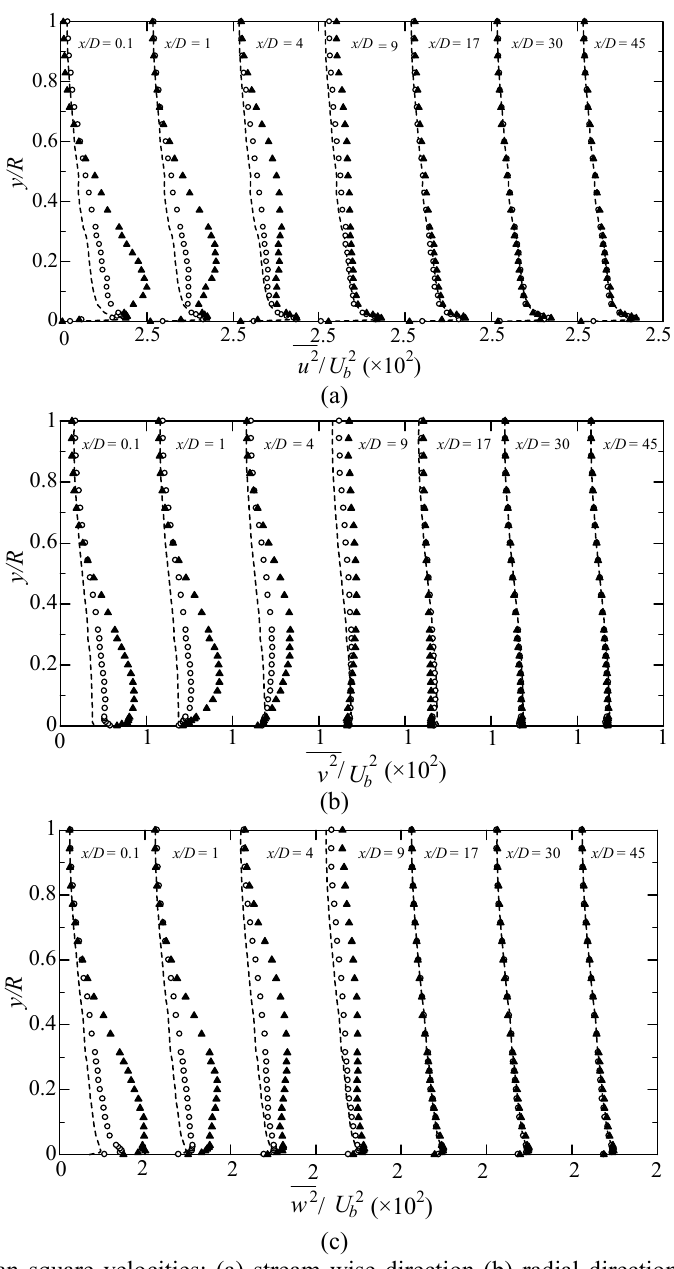
Fig. 5 The mean square velocities; (a) stream wise direction (b) radial direction (c) span wise direction (same symbols as Fig. 3)